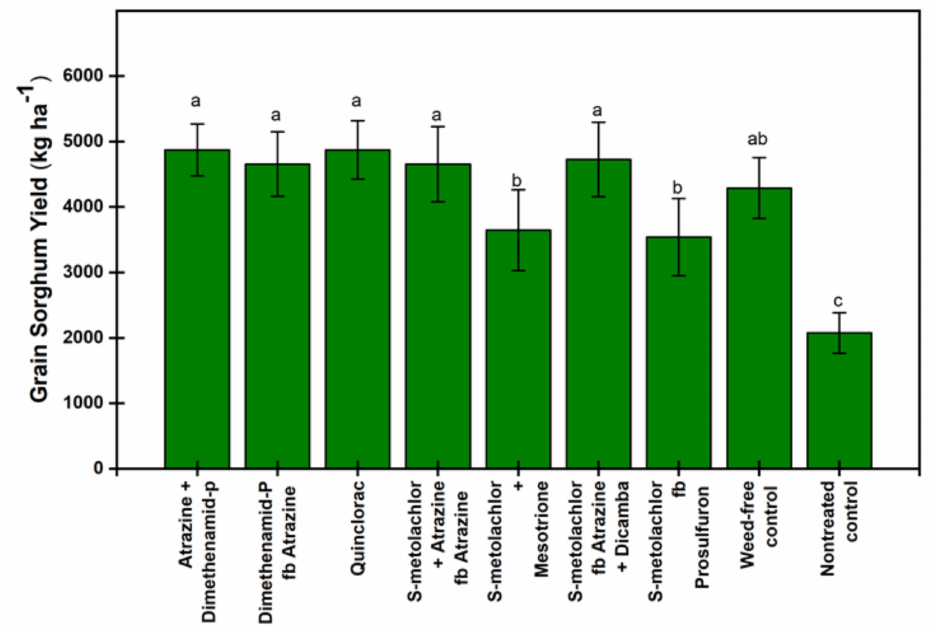
Figure 7. Grain sorghum yield as a ff ected by di ff erent herbicide treatments. Data were pooled over three years. The same letters on bars indicate no significant di ff erences at p < 0.05, according to Fisher’s least significant di ff erence